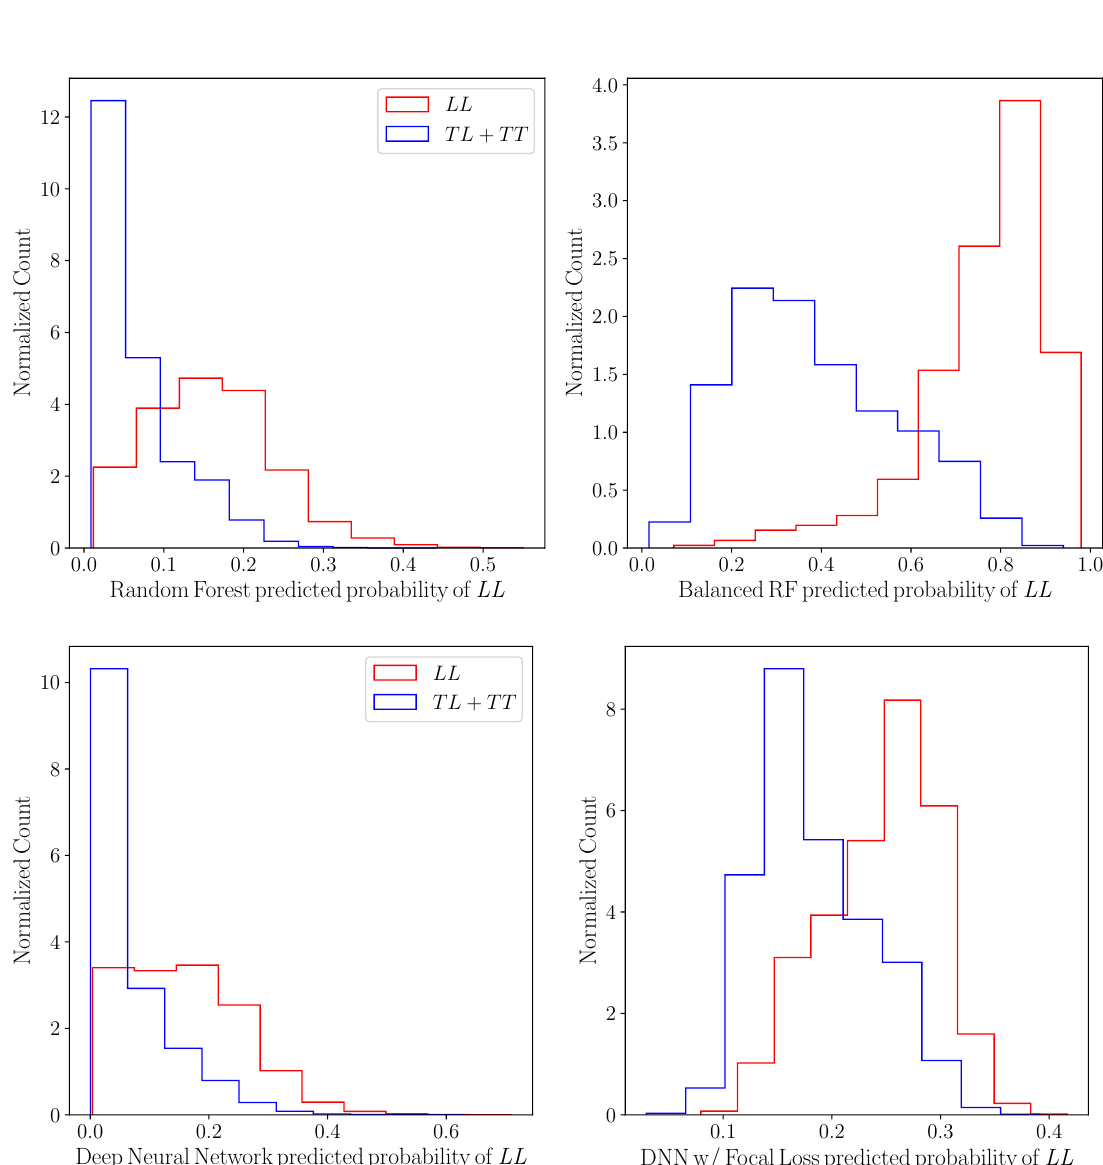
Figure 3: Histograms for the probability the event will be predicted to be an LL event when it is in truth an LL event (red distributions) or when it is actually an T L + T T event (blue distributions). The top row shows the random forest models, and the bottom row shows the DNN